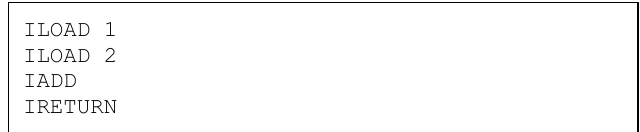
Fig. 2. First bytecode fragment decompilation result.